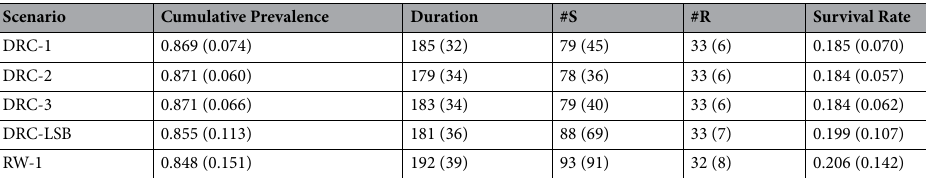
Table 1. Summary impacts of a modeled Ebola virus outbreak entering the Virunga Massif population of mountain gorillas. Scenario = gorilla group of an initial infected individual in the Democratic Republic of Congo (DRC) or Rwanda (RW), or infected lone silverback (LSB); Cumulative Prevalence = proportion of the 607 gorillas that became infected; Duration = days to the disappearance of Ebola virus from the population; #S = final number of Susceptible gorillas, those that never become infected; #R = final number of Recovered gorillas (those that were infected but recovered); Survival Rate = proportion of the population that survived, as either Susceptible or Recovered. Presented as mean (SD); SD—standard deviation across 500 iterations. The SE of means would each be the SD/√500 = SD/22.36.